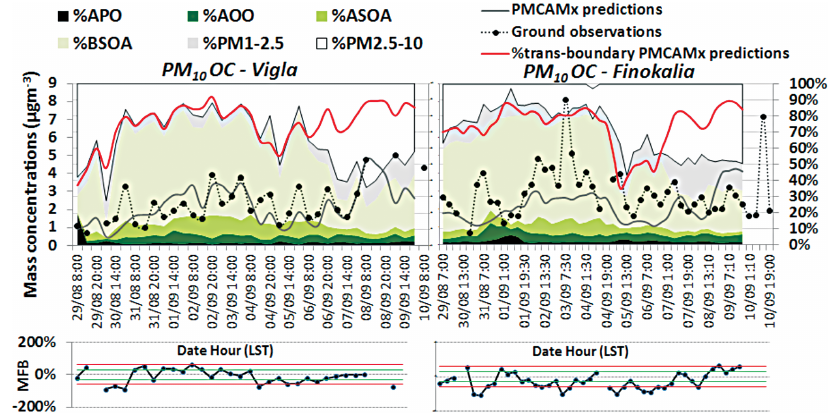
Figure 5. Comparison of PMCAMx (grey lines) with 6-h measurements (black dotted line) of total PM 10 OC concentrations (µgm − 3 ) over Vigla (left) and Finokalia (right) during 31 August–09 September 2011. The relative contribution of PMCAMx predicted trans-boundary (standard run – scenario 1, red line) to the total PM 10 OA mass is also shown. Green shaded areas represent the chemical composition of PM 1 OA predictions, grey shaded area shows the organics in the PM 1 − 2 . 5 size range, while the remaining (white shaded area) represents the organics in the coarse fraction (PM 2 . 5 − 10 ) . All areas are percentage values. The ability of the model to reproduce observations is estimated through the calculation of the mean fractional biases (MFB), shown at the bottom. Model performance is average (good), when MFB values are within the red (green) lines (Boylan and Russell, 2006). The predicted OC is acquired by dividing OA by 2.1 (Turpin and Lim,